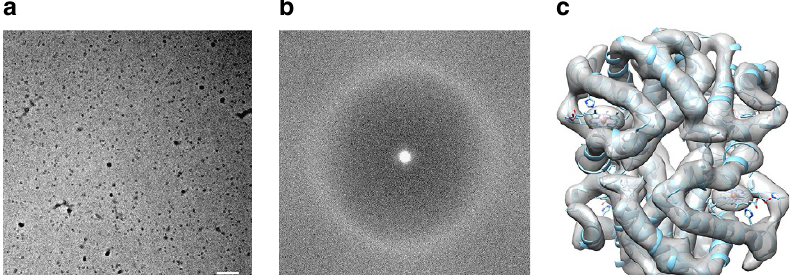
Figure 6 | In-focus phase plate imaging of 64kDa Hgb. ( a ) Electron micrograph of metHgb recorded at B 20nm underfocus with the Volta phase plate (VPP) (scale bar, 50nm). ( b ) Power spectrum of the image in a , featuring continuous signal without CTF oscillations across the frequency spectrum and visibility of the amorphous ice ring at 3.7Å. ( c ) Reconstructed 3D electron scattering potential map and fitted model of Hgb from crystal structure